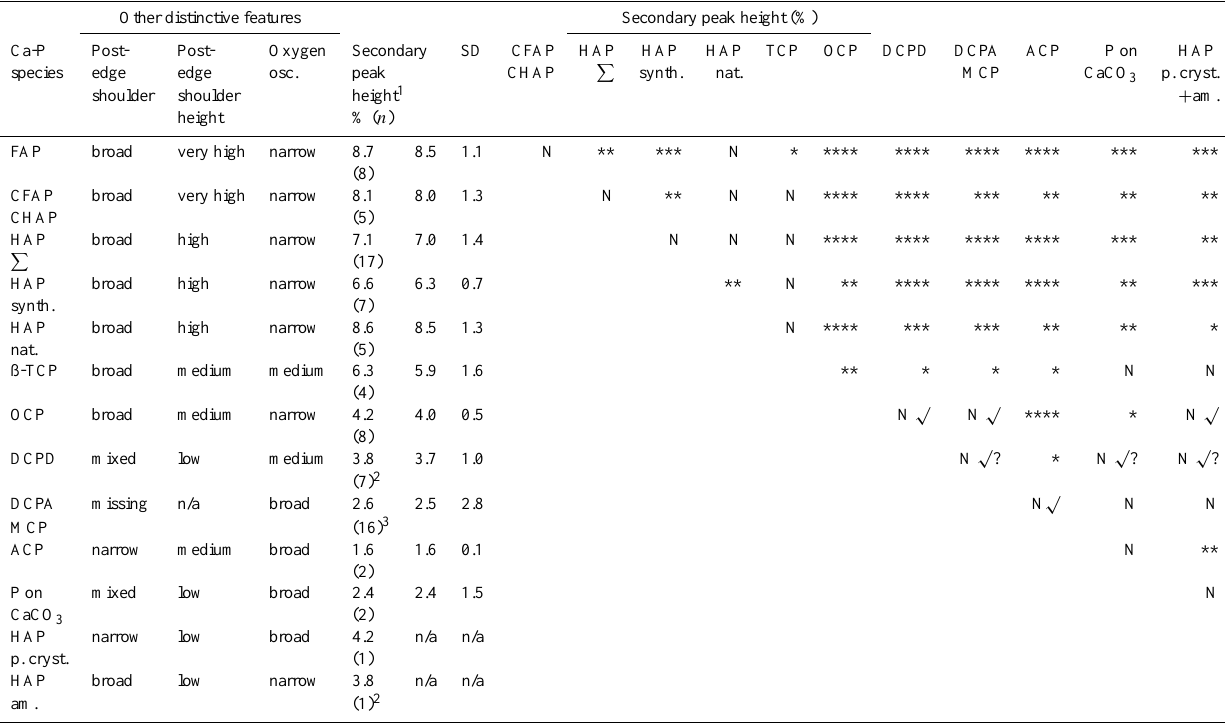
Table 2. Summary of diagnostic P K-edge XANES features for various Ca-P species. Other distinctive